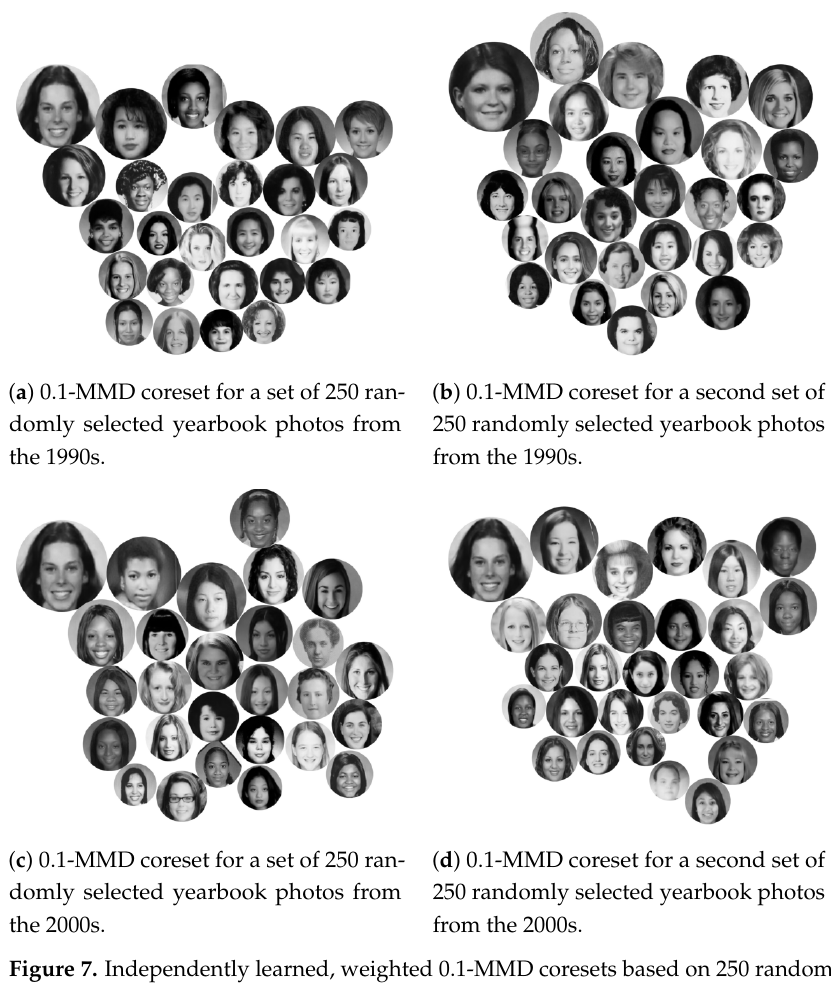
Figure 7. Independently learned, weighted 0.1-MMD coresets based on 250 random samples from a given decade. Area of each bubble is proportional to the weight of the corresponding exemplar in the